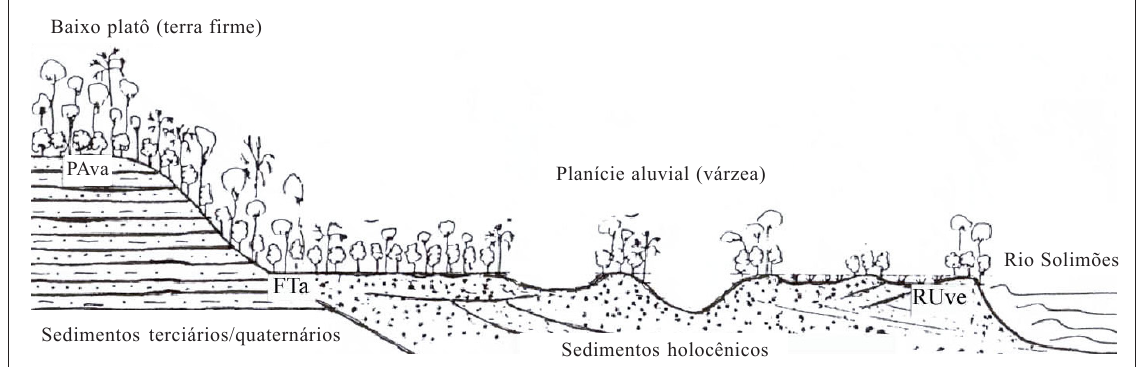
Figura 1. Bloco diagrama da distribuição dos solos na paisagem. PAva – Argissolo Amarelo Ta alumínico abrupto; FTa – Plintossolo Argilúvico alumínico abrúptico; RUve – Neossolo Flúvico Ta eutrófico.